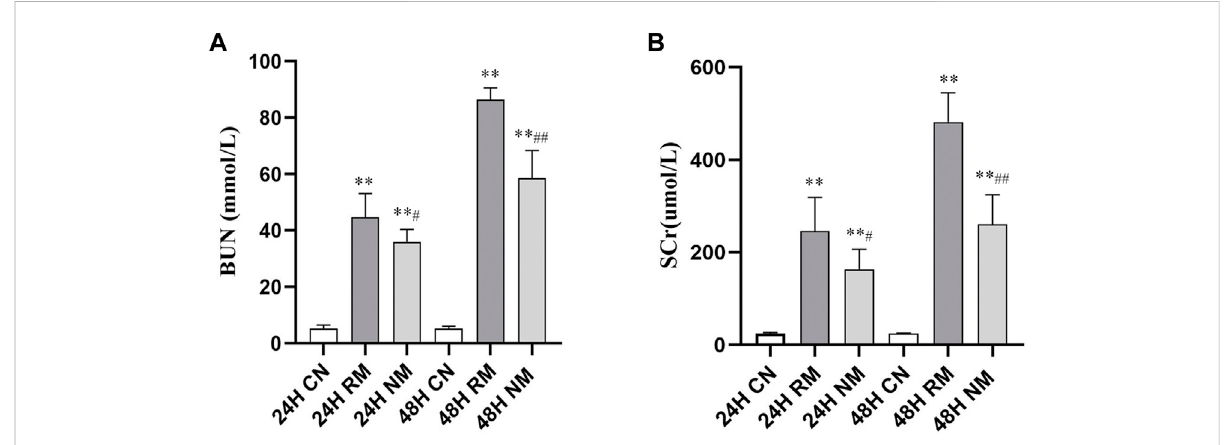
FIGURE 1 Effect of NM on serum BUN and SCr levels in RIAKI. (A) The effect of NM on glycerol induced changes in BUN and SCr. (B) The effect of NM on glycerol induced changes in SCr (* p < 0.05, and ** p < 0.01 vs. CN; # p < 0.05, and ## p < 0.01 vs.